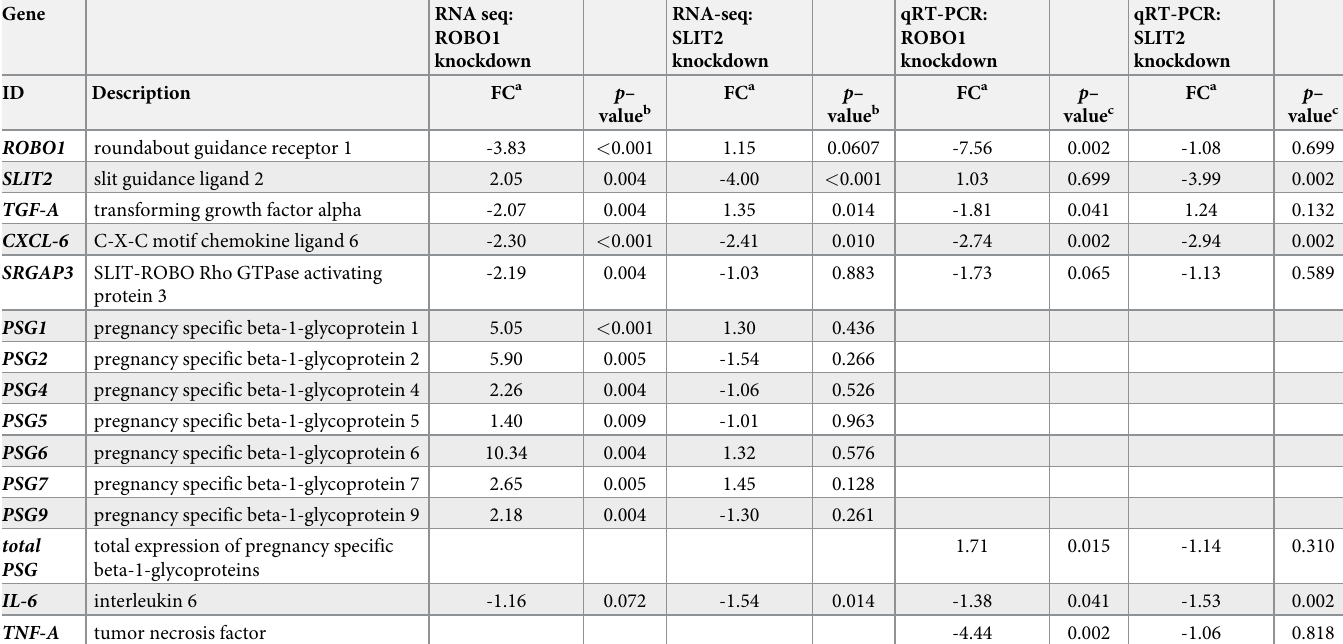
Table 5. Comparison of RNA sequencing and qRT-PCR of ROBO1 and SLIT2 genes affected by knockdown. Gene expression changes after SLIT2/ROBO1 knock- down were verified in a larger number of specimens ( n = 6) by qRT-PCR. SLIT2 and ROBO1 were silenced in HTR8/SVneo commercial cell line with siRNAs. mRNA lev- els of SLIT2/ROBO1-silenced cells were compared with mRNA levels of cells treated with negative siRNA. In addition to genes affected by gene knockdown according to RNA sequencing data, we tested the effect of knockdown on mRNA expression of well-known cytokines IL-6 and TNF-A